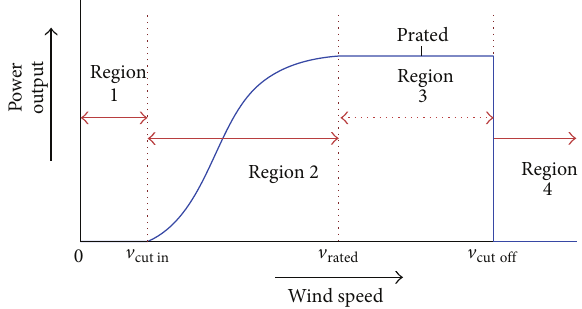
Figure 1: Typical power curve of a pitch regulated wind turbine.